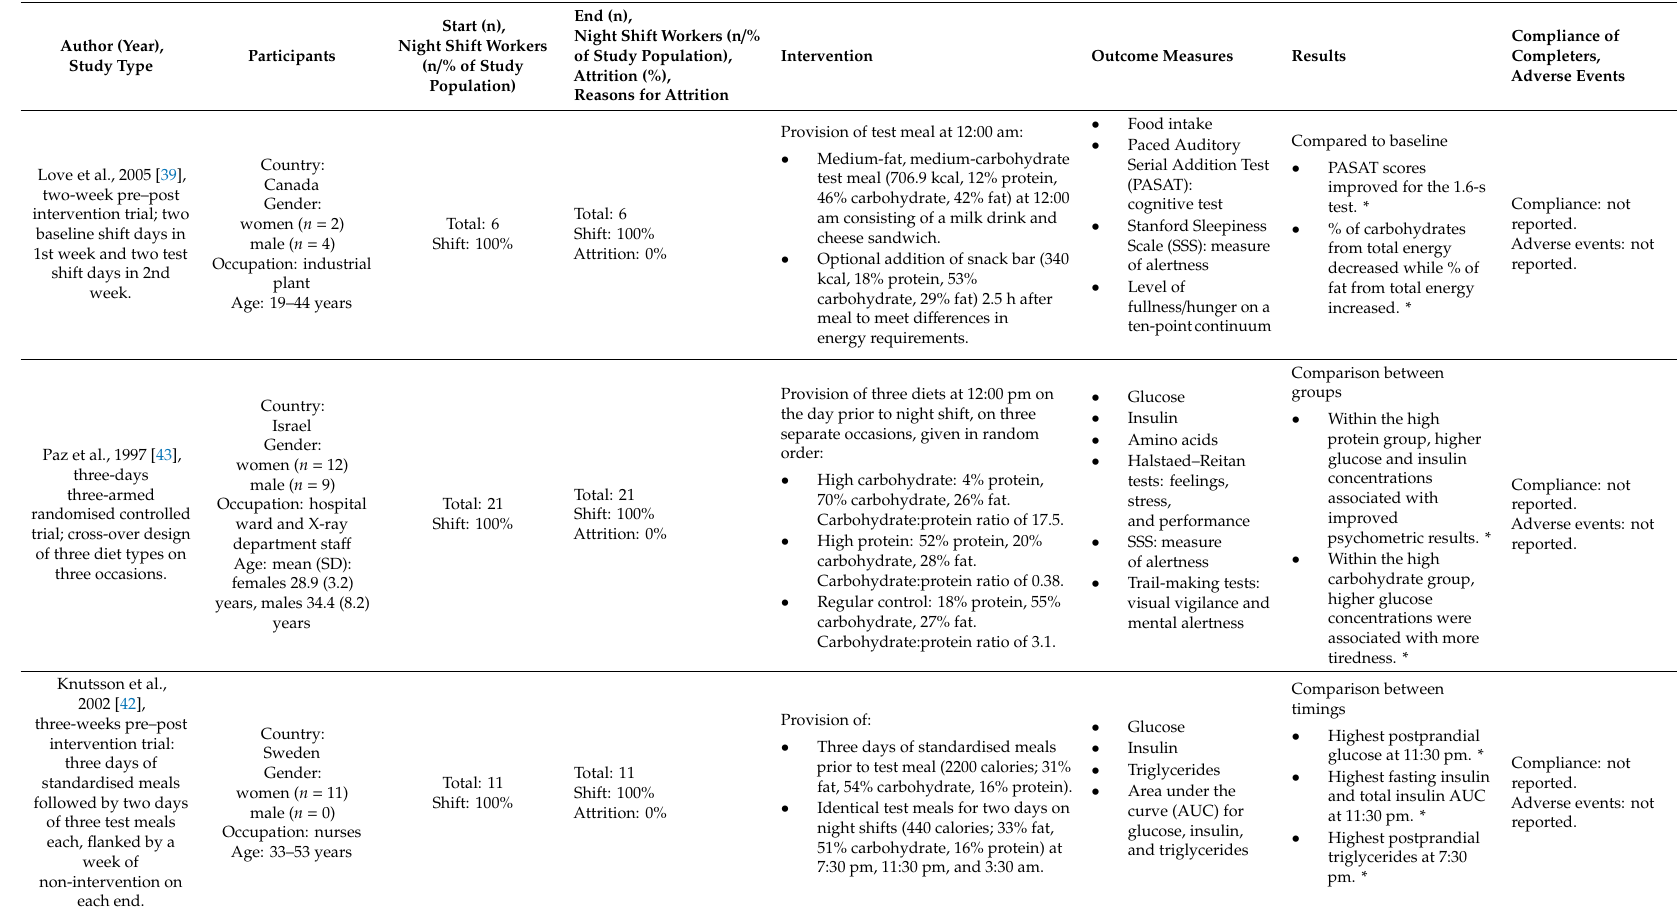
Table 1. Descriptive table of included